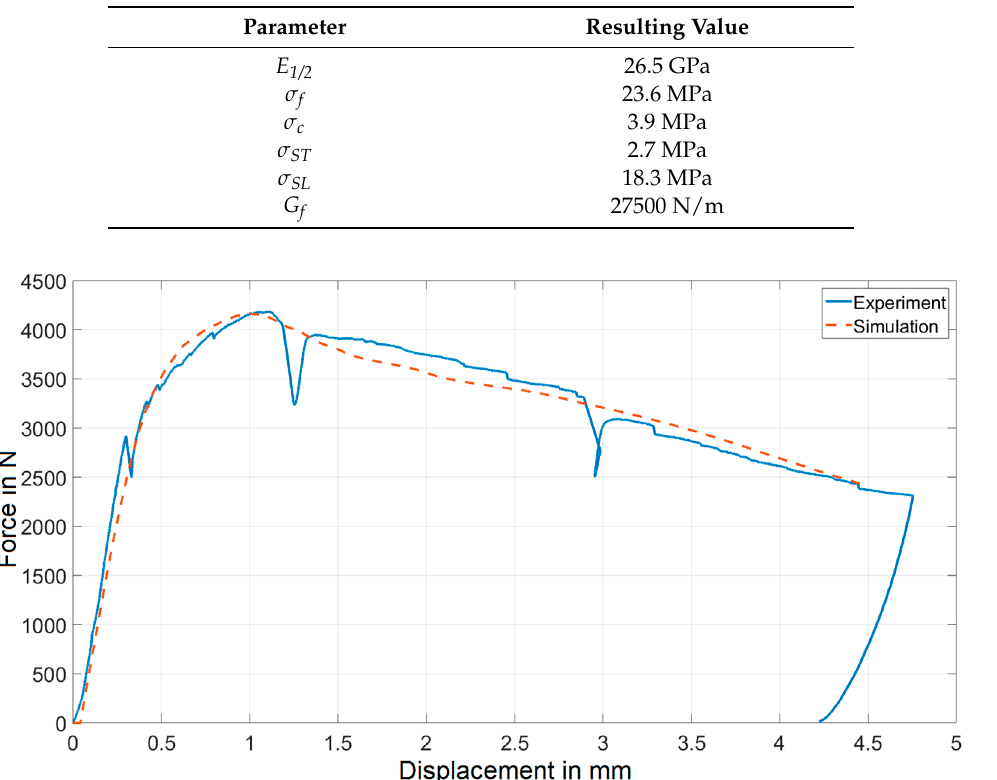
Table 1. Parameter estimates resulting from the inverse analysis.